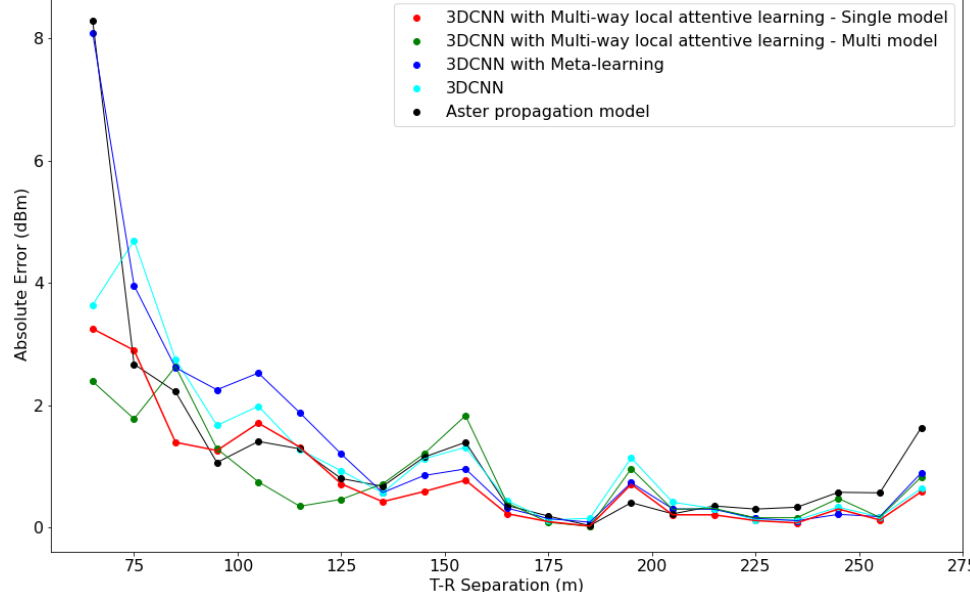
Figure 7. Absolute Error Comparison — LoS and NLoS Combined.